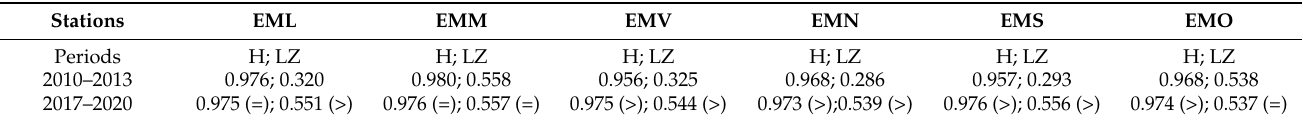
Table A2. Comparative table of the amount of wind speed according to persistence, H, and LZ complexity, where > means an increase, and = means the same